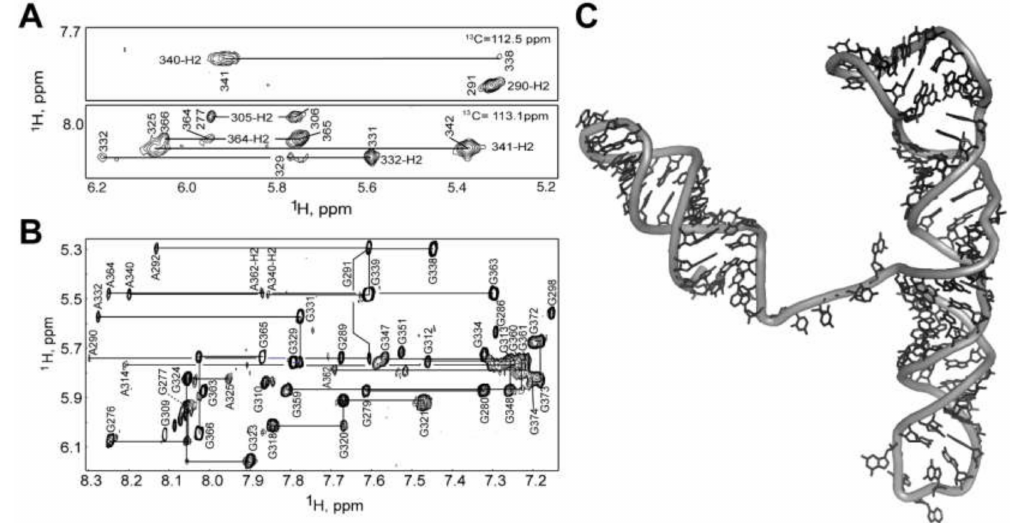
Figure 14. Improved NMR spectral quality a ff orded by 2 H-edited NMR in the studies of MoMuLV minimal packaging signal, with loop residues engineered to prevent dimerization (m Ψ CES ). ( A ) Representative strips from 3D 1 H- 13 C correlated with the NOESY spectra obtained for 13 C-labeled m Ψ CES . ( B ) Portion of a 2D NOESY spectrum obtained for an m Ψ CES sample containing protonated guanosines and with all other predeuterated nucleotides (breakthrough signals from incomplete deuteration of adenosines are also visible). Linewidths are significantly narrower in the 2 H-edited spectra. ( C ) 3D NMR structure of m Ψ CES . Adapted from [327], with